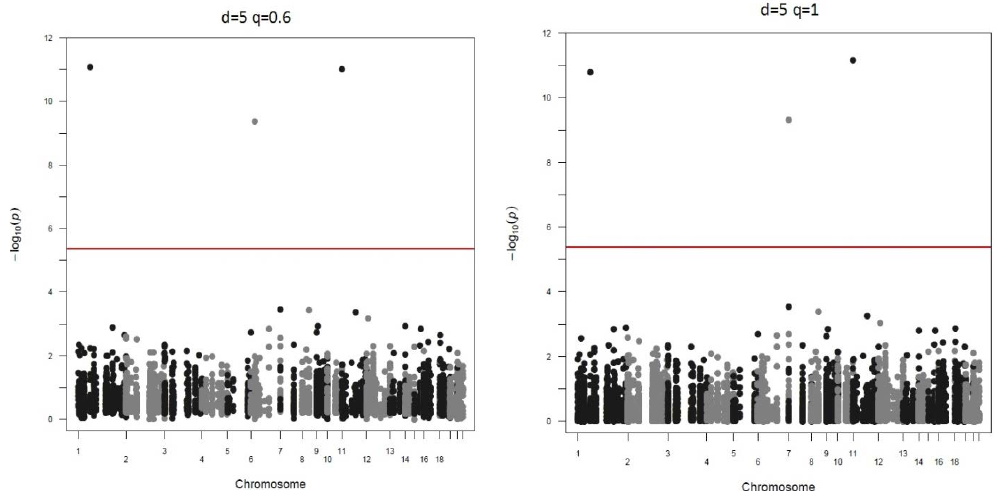
Figure 3. Real data-based studies when down-sample ratio is 5.